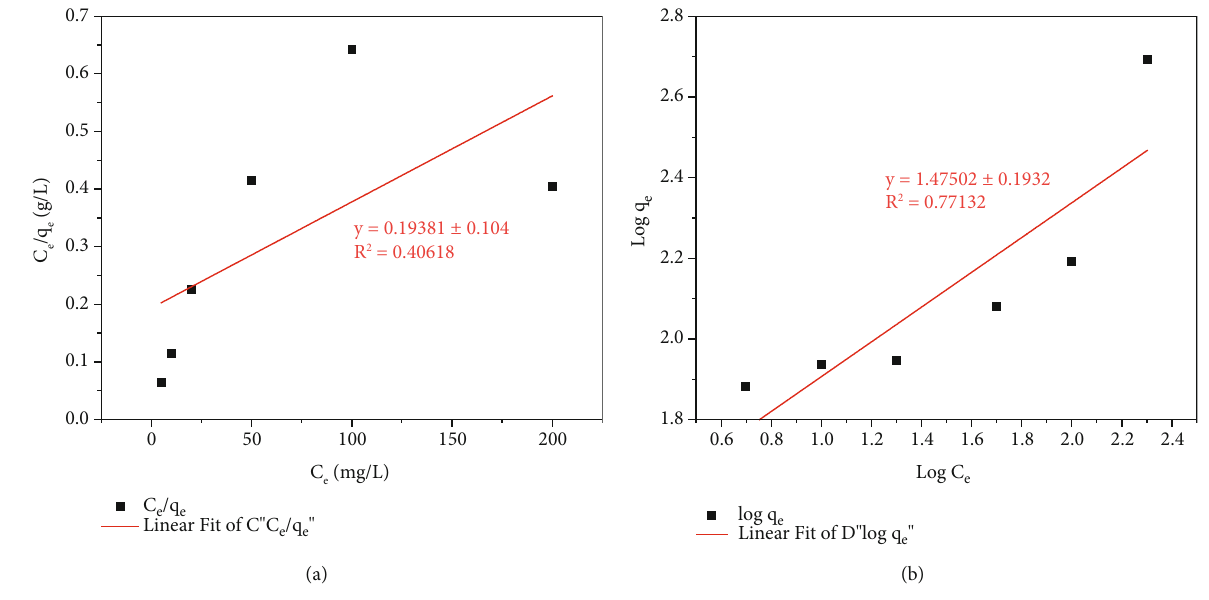
Figure 8: (a) Langmuir model and (b) Freundlich model for Pb 2+ adsorption. Table 4: Comparison between various adsorbents on the adsorption capacities q e (mg/g) for Pb(II) removal. Adsorbent q e (mg/g) Ref.